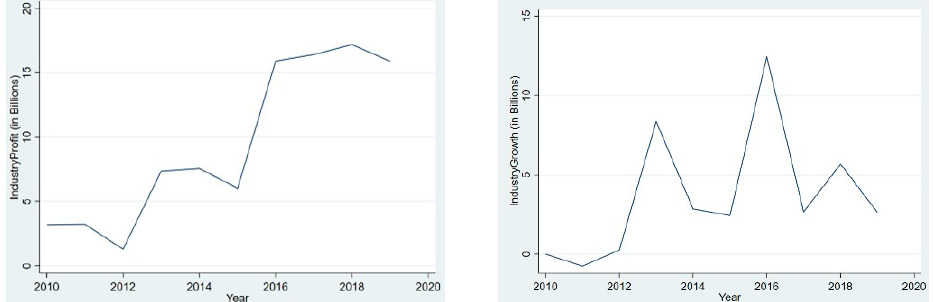
Figure 1. The figure on the left shows weaker currency and higher demand (shift from demand from D 0 to D 1 ) have led to substantially higher prices (from P 0 to P 1 ) and profits since the supply curve is quite inelastic. The figure on the right shows the change in price of farmed fish. (Source: Norwegian public register for firms, Brønnøysund Register Center).